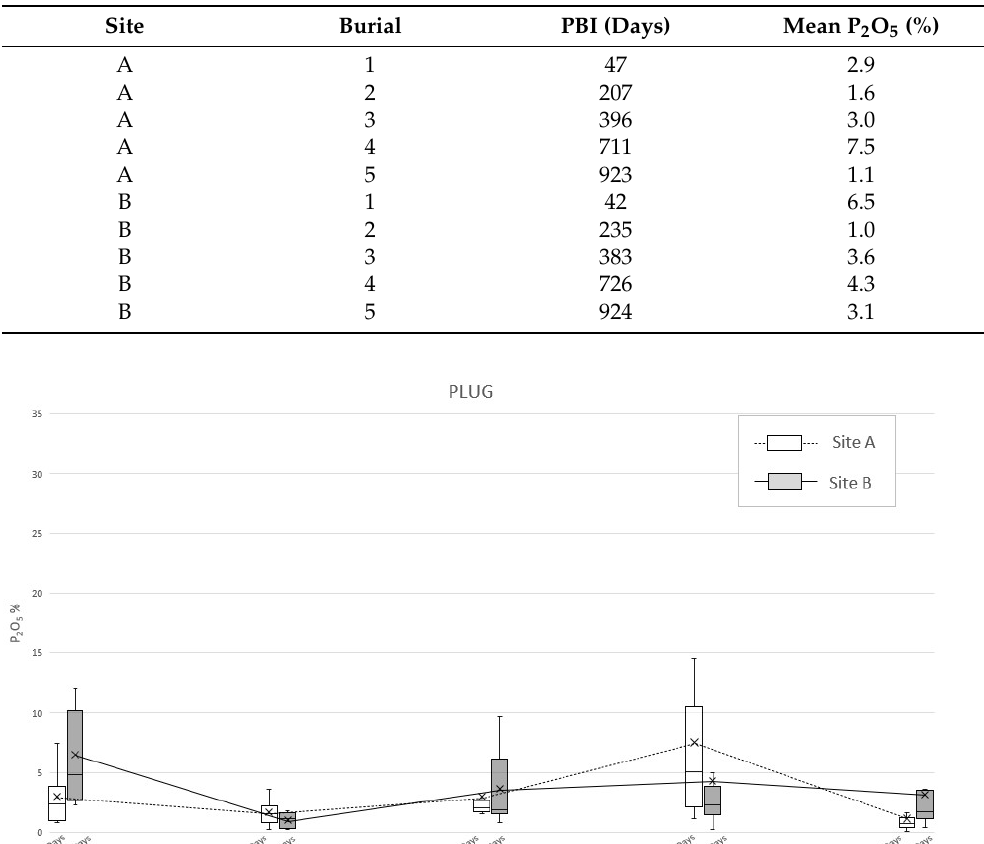
Table 3. Summary of the mean phosphate concentration (P 2 O 5 ) found in each “plug” sample from site A and B at different Post Burial Intervals (PBIs) obtained using SEM-EDS analysis.